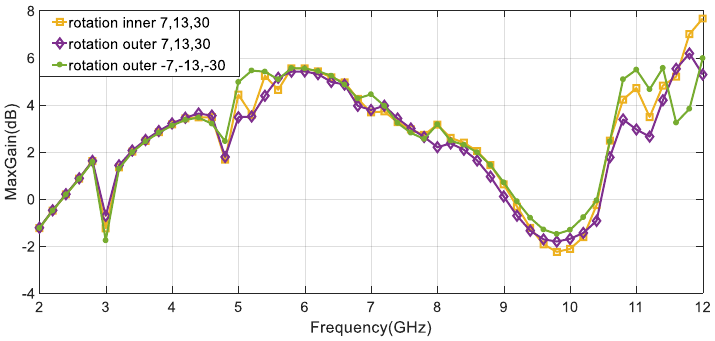
Figure 35. S 11 for multiple C-SRR variations.